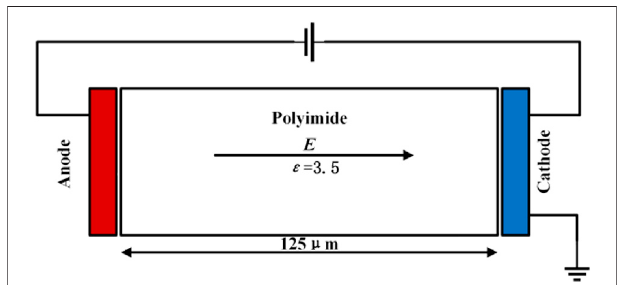
FIGURE 4 | Simulation